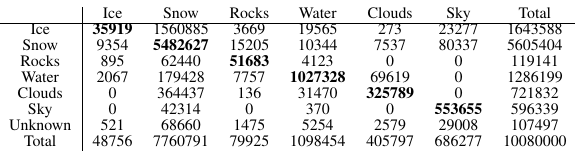
Table 4. Confusion matrix for the test-images with real classes on the left and predicted classes on the